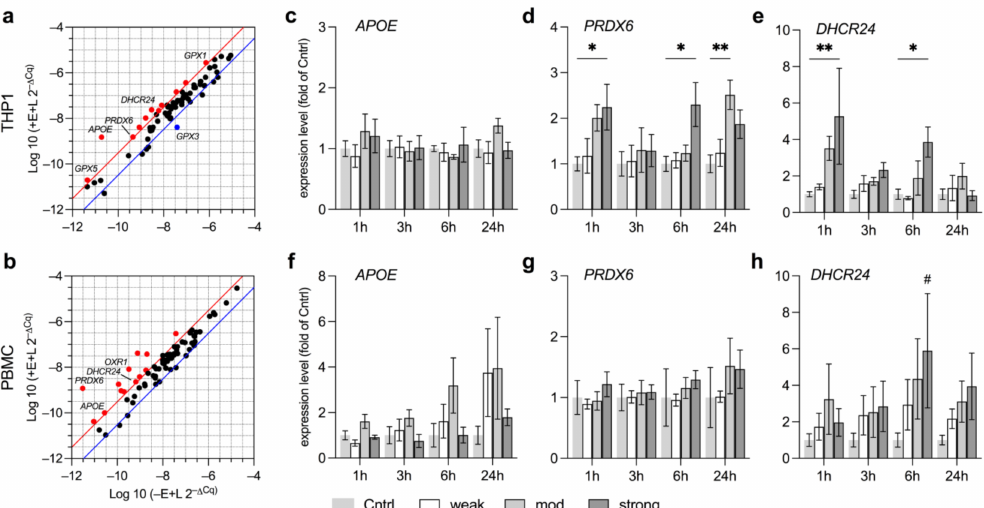
Figure 4. Target screening and evaluation of transcriptional responses of key hits following EMF exposure at varying field strengths. ( a , b ) PrimePCR of THP1 ( a ) and PBMC ( b ) exposed to stEMF for 3 h reveals transcriptional deregulation (upreg- ulation, red; downregulation, blue) of several anti-oxidative defense genes (considered if more than 4-fold deregulated). Relevant targets are indicated by name. Three key hits ( APOE , PRDX6 and DHCR24 ) representative for both THP1 ( c – e ) and PBMC ( f – h ) were tested at different time points and field strengths ( N = 3, n = 2). Data are given as fold of Cntrl (mean ± SEM). * p < 0.05 and ** p < 0.01 as indicated. # p < 0.08 representing a